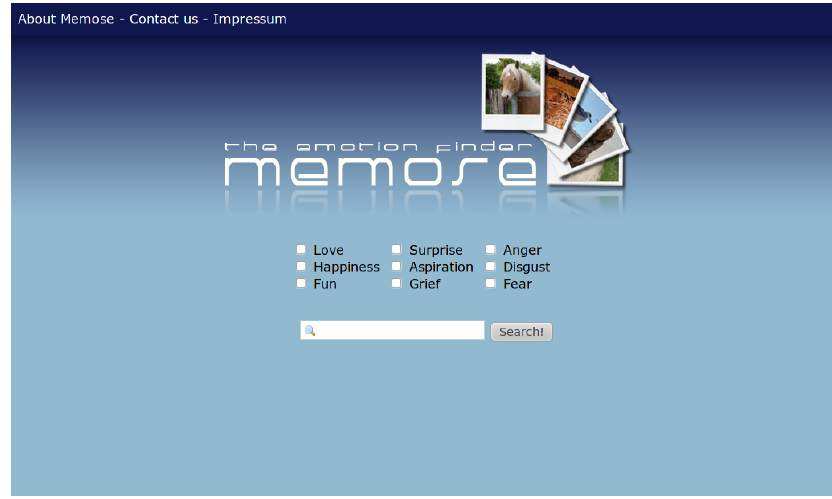
Figure 6. First version of the MEMOSE search